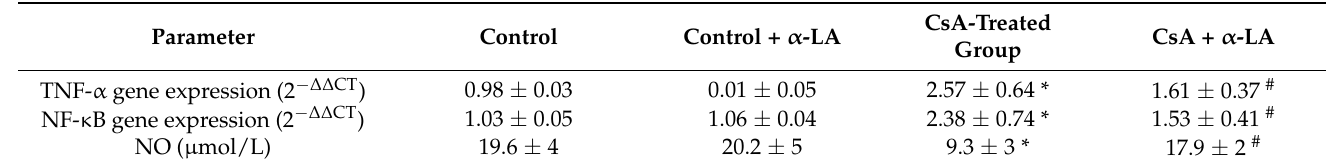
Table 5. Effect of α -LA administration on hepatic tissue mRNA expression of TNF- α and NF- κ B genes and serum NO in CsA-treated animals.